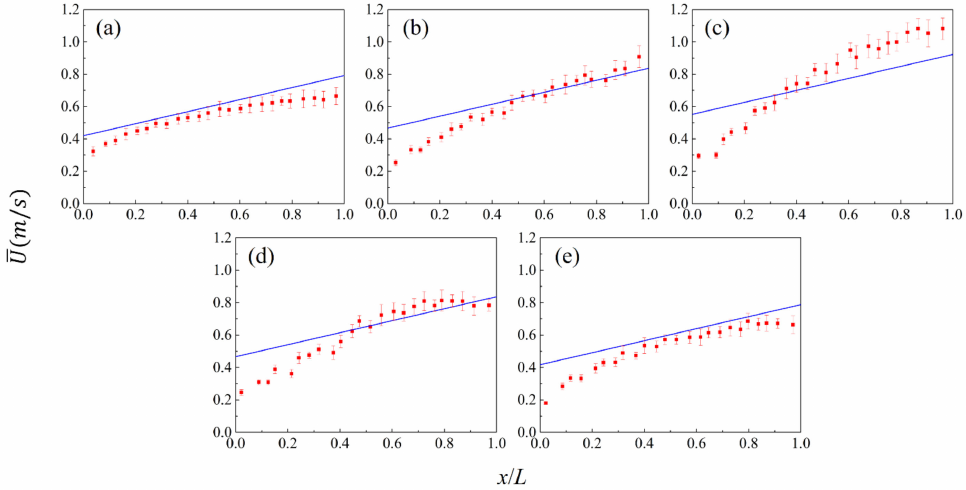
Figure 13. Comparisons of measured velocities and Ritter’s solution above the plate for T = 0.45. Red dot: measured depth–averaged velocity, blue line: Ritter’s solution: ( a ) case 1, D / h = 6/30, H / h = 10/30; ( b ) case 2, D / h = 4/30, H / h = 10/30; ( c ) case 3, D / h = 2/30, H / h = 10/30; ( d ) case 4, D / h = 2/30, H / h = 8/30; and ( e ) Case 5, D / h = 2/30, H / h =